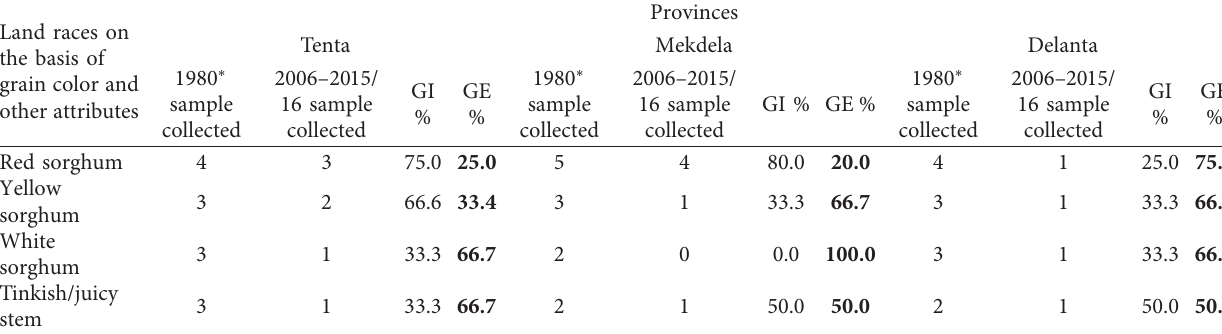
Table 4: Estimated GE for local sorghum grains collected in the same area in 1980 and 2006–2015/2016. Land races